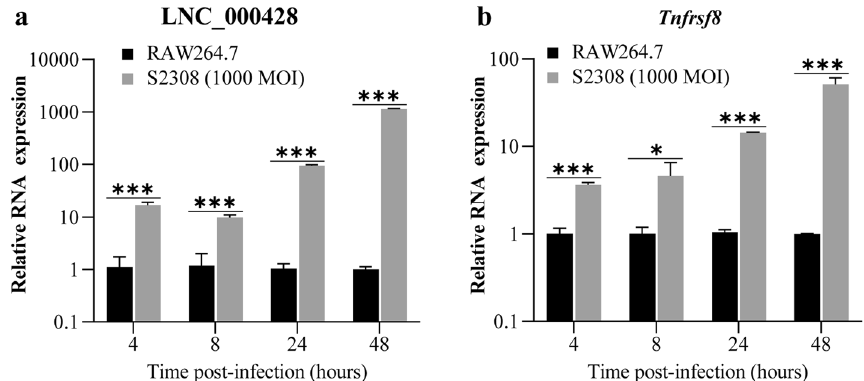
Figure 5. Spatio-temporal expression of LNC_000428 and its anti-sense gene Tnfrsf8 in S2308-infected RAW264.7 cells determined by qRT-PCR. Expression of LNC_000428 ( a ) and Tnfrsf8 ( b ) in RAW264.7 cells with a S2308 infection at a MOI of 1000 for 4, 8, 24 and 48 h were detected by qRT-PCR. Relative RNA expression was decided by normalizing the expression of lncRNA to Gapdh . * P < 0.05; *** P < 0.001.